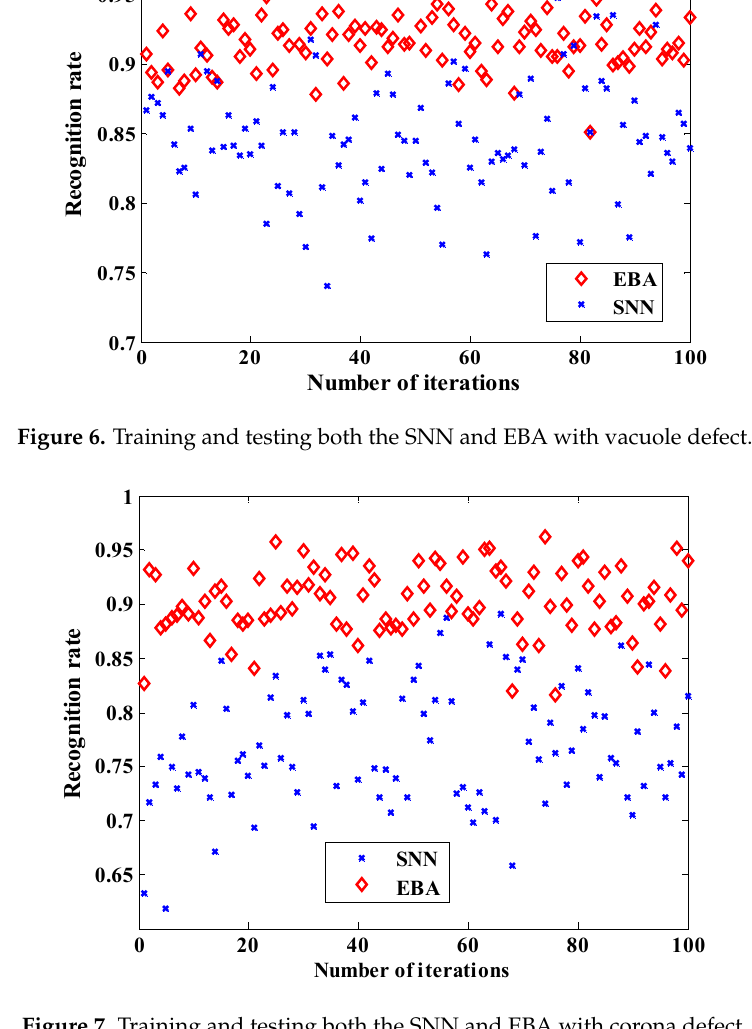
Figure 7. Training and testing both the SNN and EBA with corona defect.